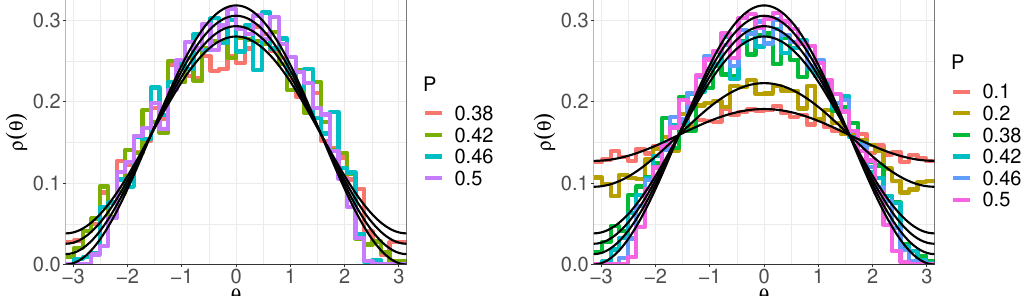
) and [Right] µ = 1 . 6 , N = 32 , c in black. A clear 2 π